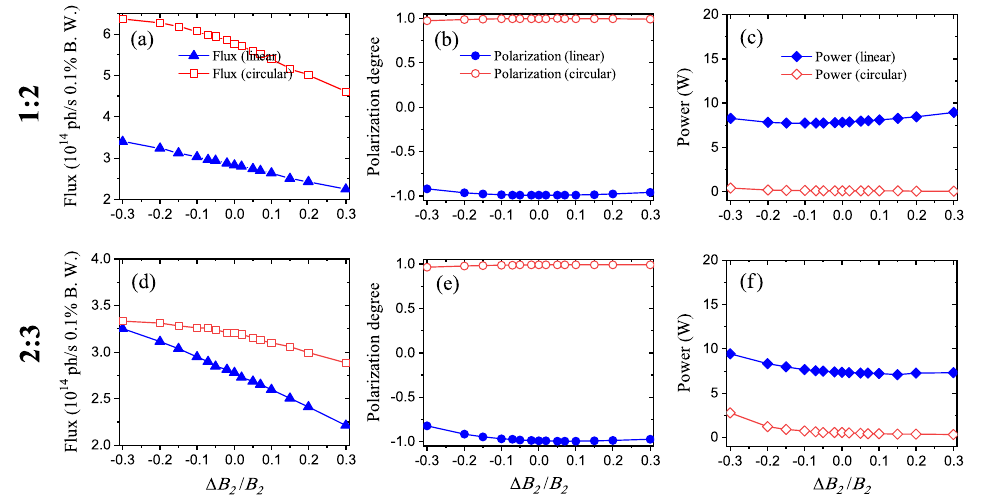
FIG. 13. The flux (left), polarization degree (middle) and power (right) depend on the deviation of field amplitude B 2 . Upper subfigures are corresponding to the Fig. 8 AMPU and lower subfigures are corresponding to the Knot AMPU,